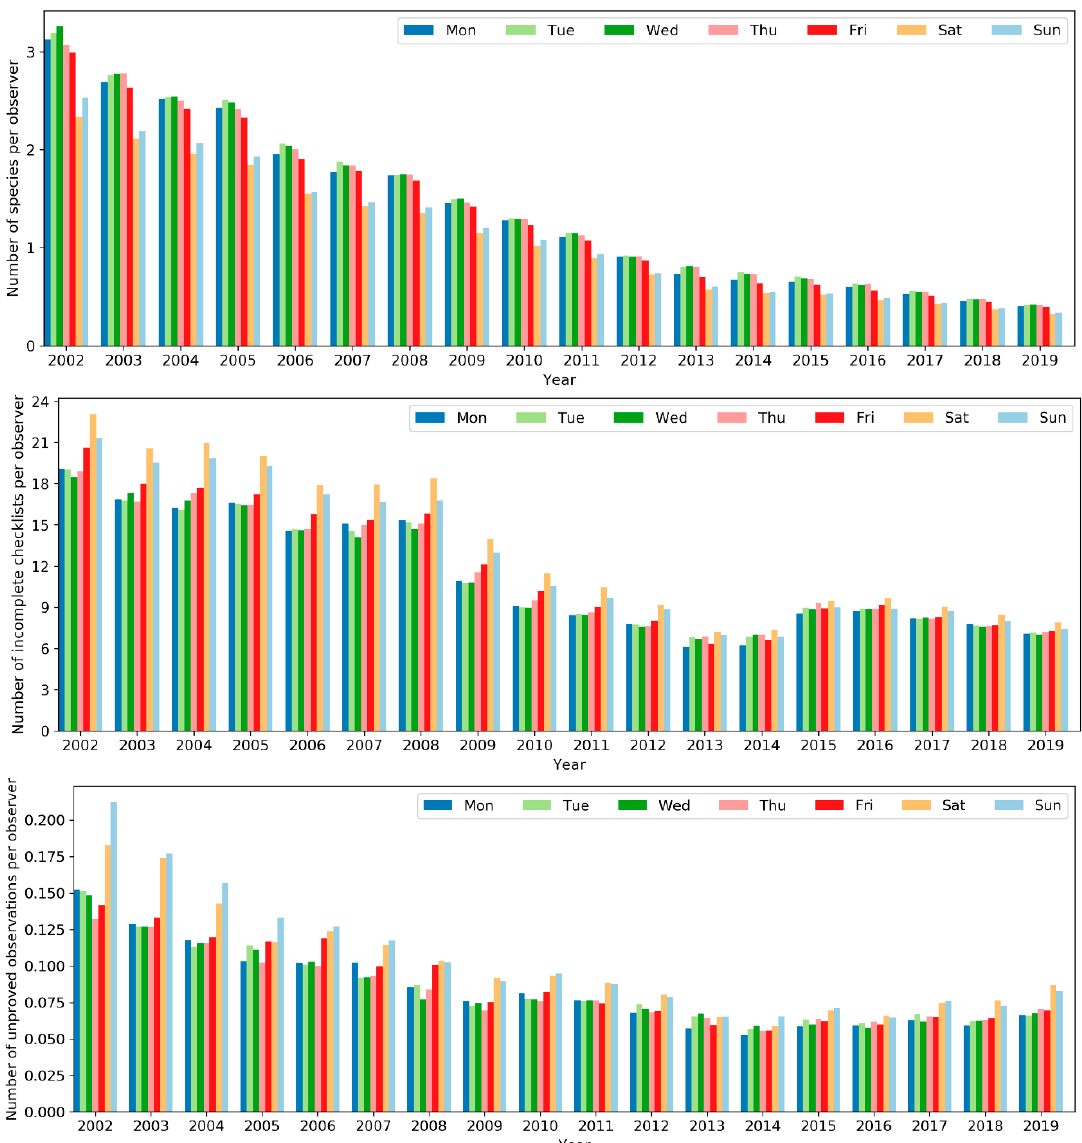
Figure 22. Number of species ( top ), incomplete checklists ( center ), and unapproved observations ( bottom ) per observer across the days of the week.